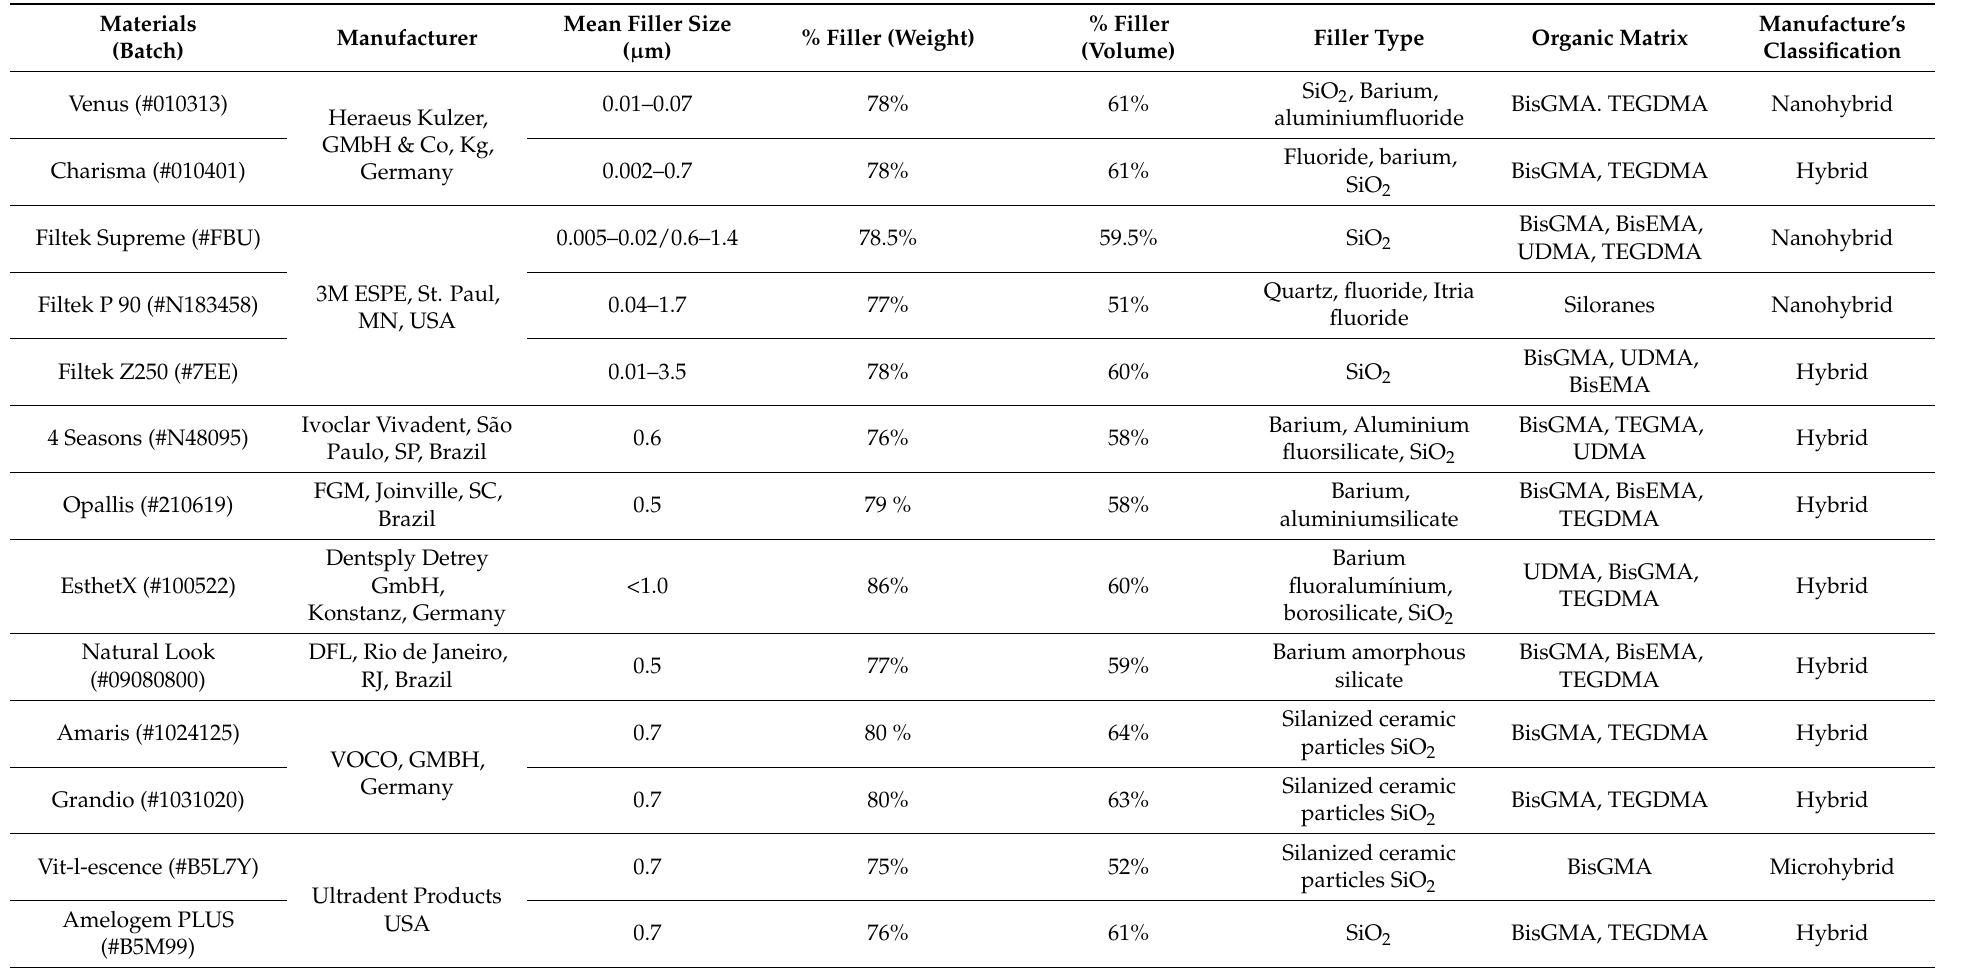
Table 1. Materials used in this